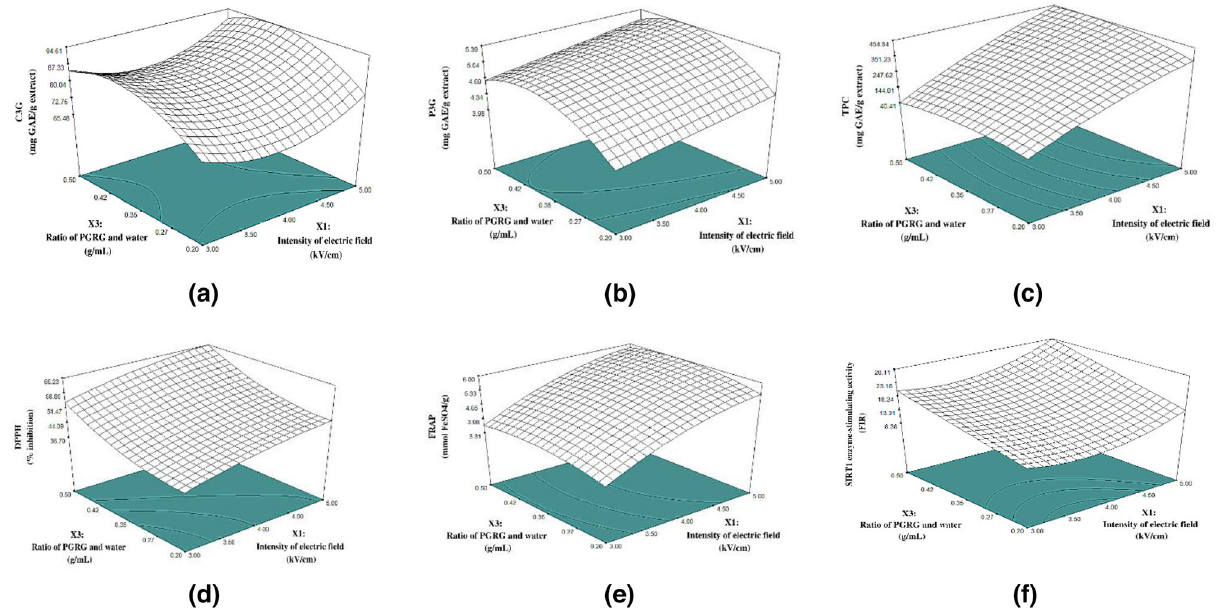
Figure 3. Contour plots effects between intensity of electric field (X 1 ; kV/cm) and ration of BRG and water (X 2 ; g/mL) with fixing number of pulse value at 3000 pulse on ( a ) C3G, ( b ) P3G, ( c ) TPC, (d) DPPH, ( e ) FRAP and ( f ) Surtuin1-stimulation activity Adj. R 2 = 0.9943 and Pred. R 2 = 0.9943 indicated acceptable correlation between the experimental values and model predicted by the equations.